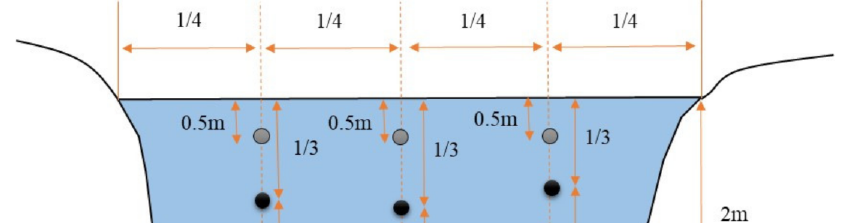
Figure A1. Sampling